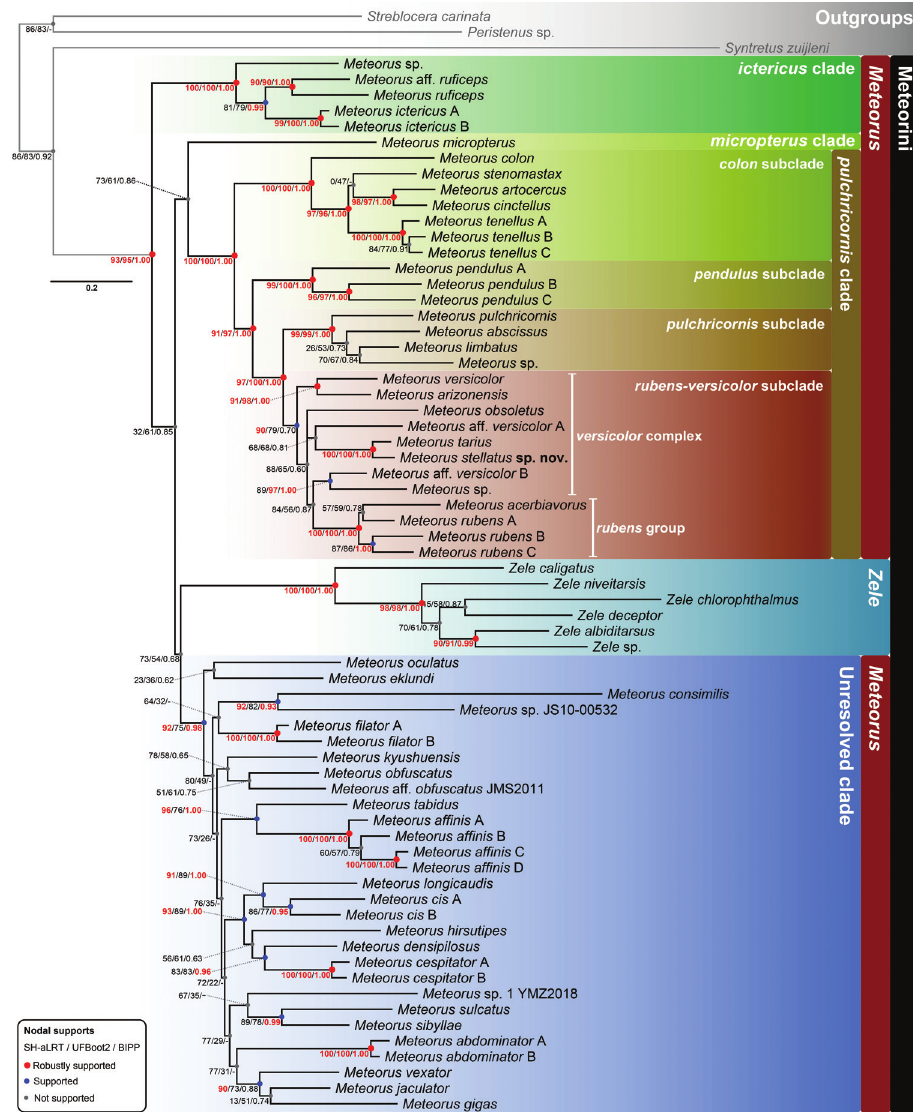
Figure 9. Maximum likelihood tree of Meteorini generated using IQ-TREE (BIPP, Bayesian inference posterior probabilities; SH-aLRT, a Shimodaira-Hasegawa-like approximate likelihood ratio test; UF- Boot2, ultrafast likelihood bootstrap